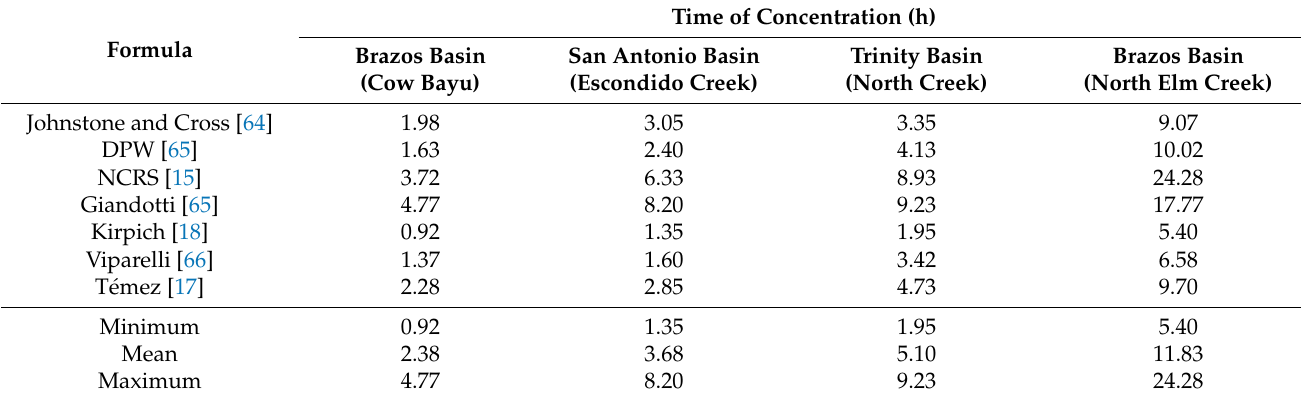
Table 2. Time of concentration (hours) of the basins of Case Study 1 according to the formulations described in Grimaldi et al. [10] plus the T é mez [17] formula and minimum, mean, and maximum values of the time of